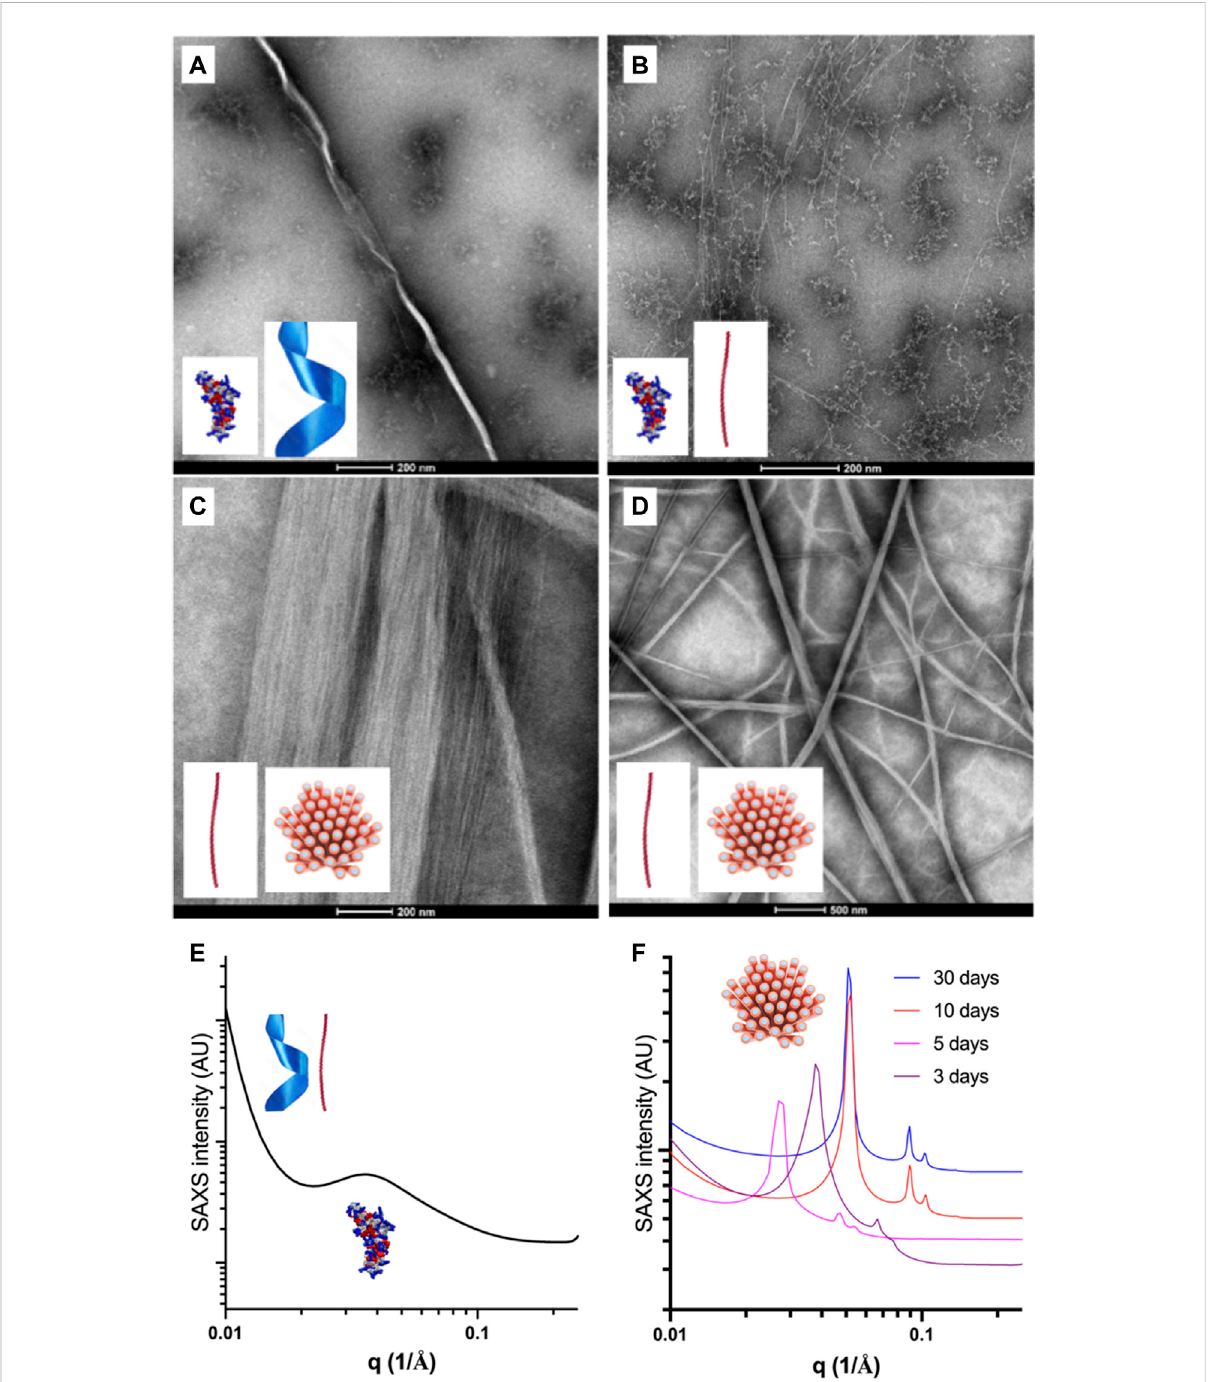
FIGURE 5 Representative transmission electron micrographs and SAXS patterns of the self-assembled species formed in water by Priscilicidin (Fmoc- WWRR-NH 2 ) over the concentration-time space. (A) Nanoribbon and oligomers for 1% wt Pris ac, 1 week. Scale bar 200 nm; (B) Nano fi brils and extended oligomers for 5% wt Pris ac < 12 h. Scale bar 200 nm; (C) Single and aligned nano fi brils (into nano fi bers) for 5% Pris ac, 1 week. Scale bar 200 nm; (D) Single and aligned nano fi brils (into nano fi bers) for 5% Pris ac, 7 days. Scale bar 500 nm. (E) SAXS patterns recorded at 25 ° C for 1% Prisac,30 daysinterpretedasacoexistenceofoligomers,nanoribbonsandnano fi brils(Table4); (F) SAXSpatternsrecordedat25 ° Cfor10%Prisacas a function of time interpreted as maturing hexagonal networks of nano fi brils (Table